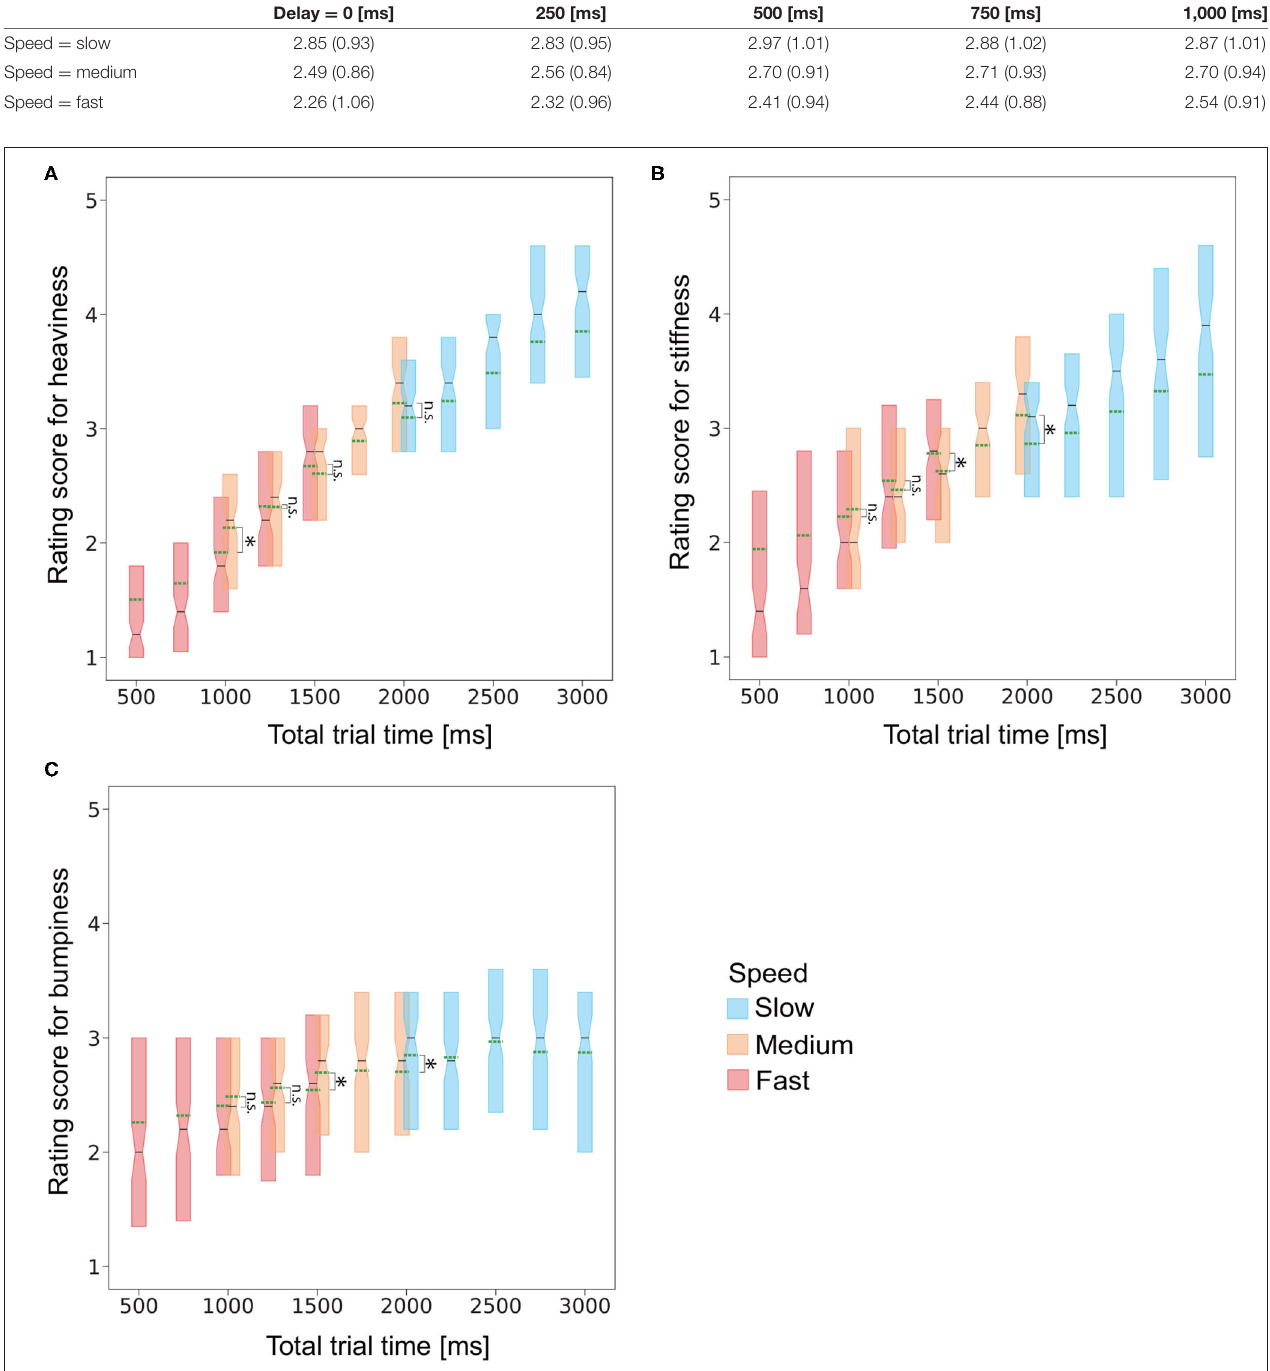
FIGURE 3 | Box plot of the (A) heaviness, (B) stiffness, and (C) bumpiness rating scores as a function of total trial time. Green dashed lines denote the averaged values of the rating scores. The Asterisks and n.s. denotes that the difference was significant (i.e., Bonferroni corrected p < 0.05) and not significant (i.e., Bonferroni corrected p > 0.05),